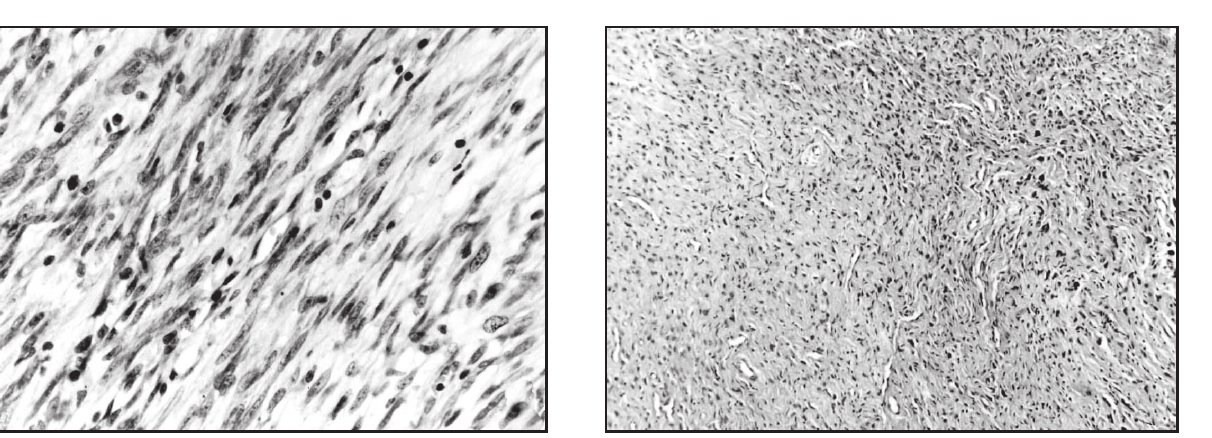
Figura 3 – Caso 2/H.E. Parênquima neoplásico com padrão predominantemente vorticilar (40x)